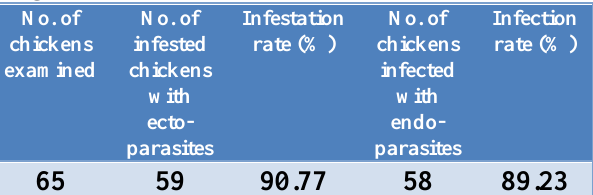
Prevalence of ecto and end- parasites in domestic chickens in Sulaimani